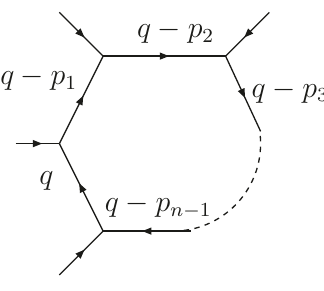
Figure 1 . One-loop diagram with n external legs.